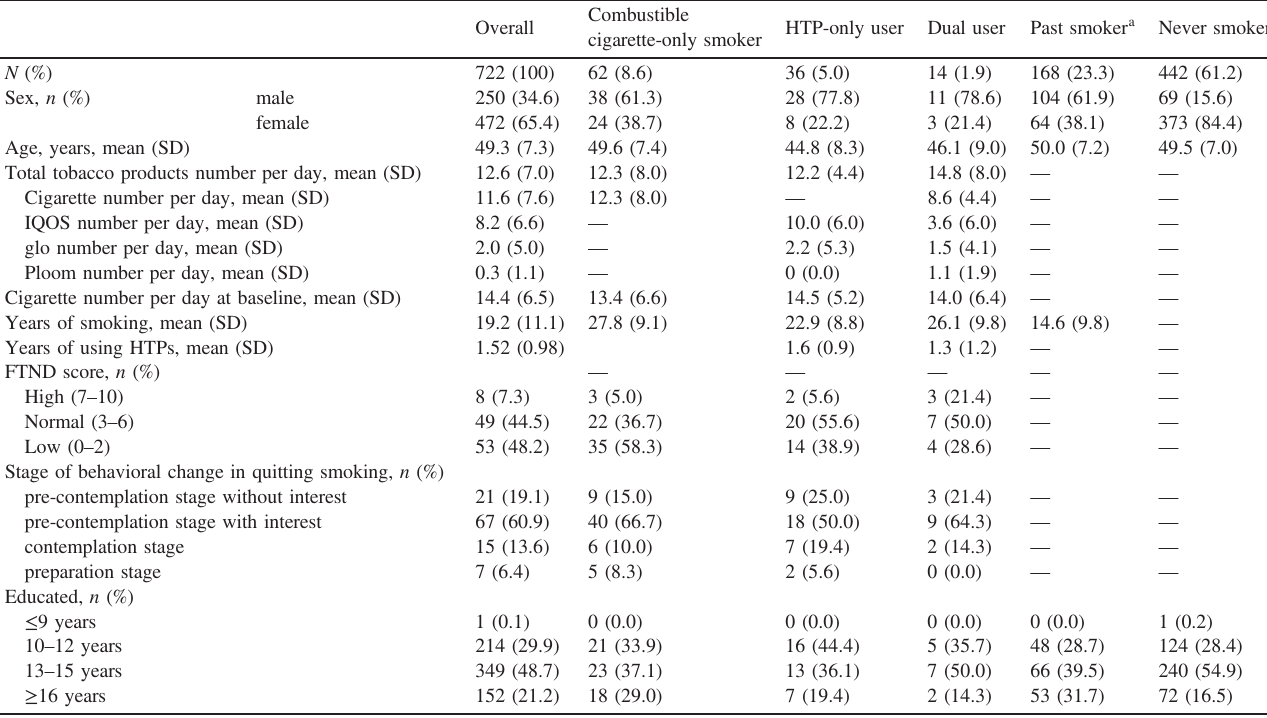
Table 2. Characteristics of the worksite population in the follow-up